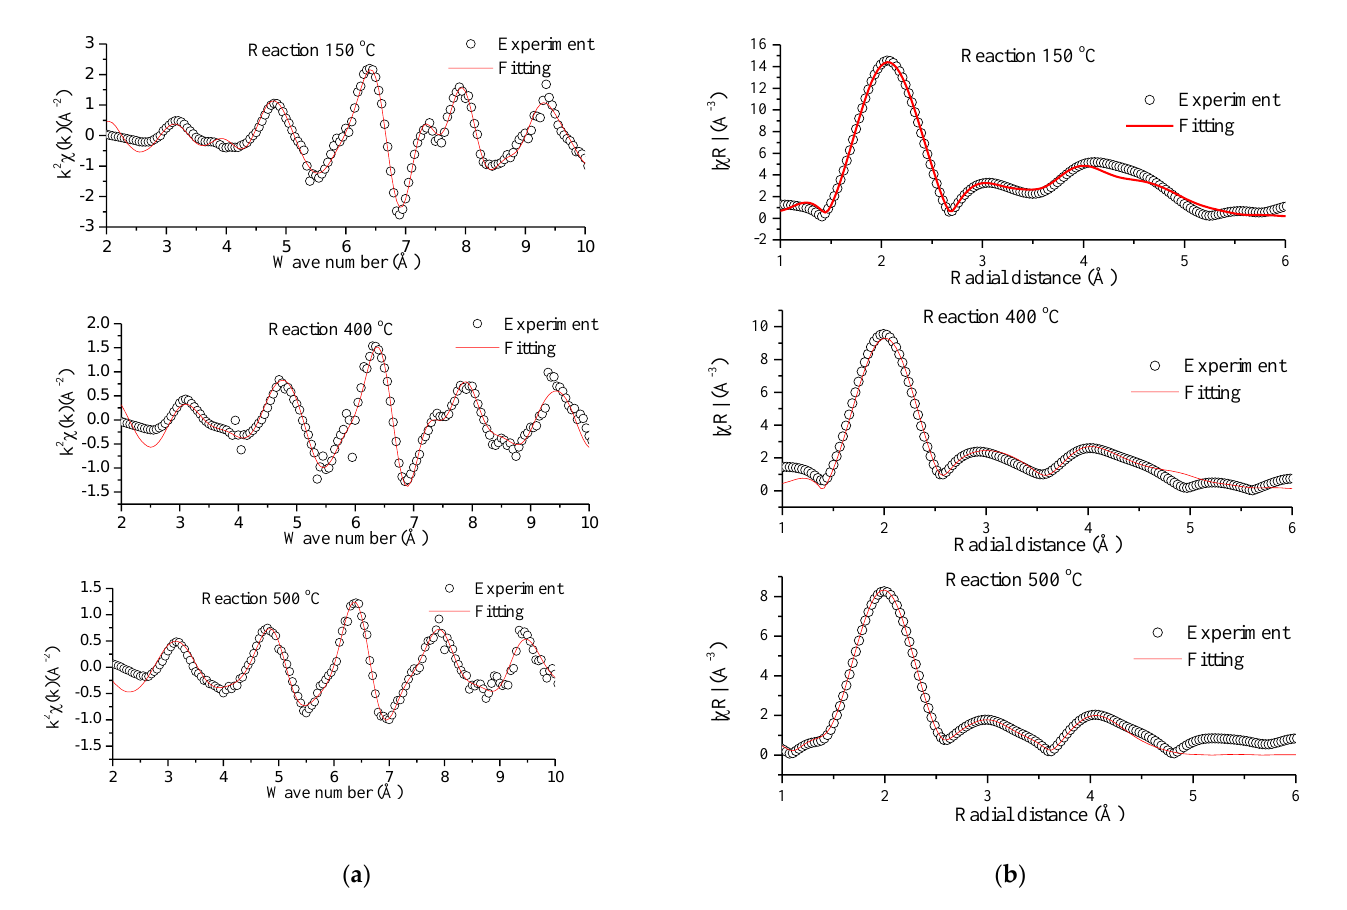
Figure 9. ( a ) The k 2 weight EXAFS and ( b ) the radial function of Ni K-edge EXAFSspectra of 15wt%Ni/ZA_5D_9h under CO 2 methanation condition at 150, 400, and 500 ◦ Table 2. The best fitting parameter of 15wt%Ni/ZA_5D_9h.